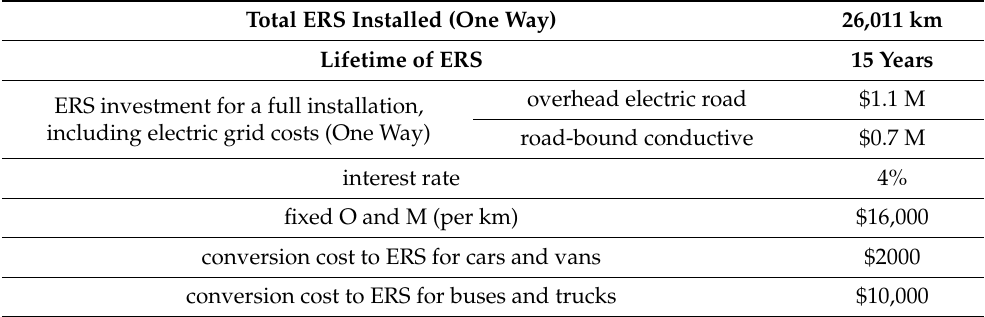
Table 3. Key assumptions for ER infrastructure in this study, based on a conductive charging system. Total ERS Installed (One Way) 26,011 km Lifetime of ERS 15 Years overhead electric road $1.1 M ERS investment for a full installation, including electric grid costs (One Way) road-bound conductive $0.7 M interest rate 4% fixed O and M (per km) $16,000 conversion cost to ERS for cars and vans $2000 conversion cost to ERS for buses and trucks